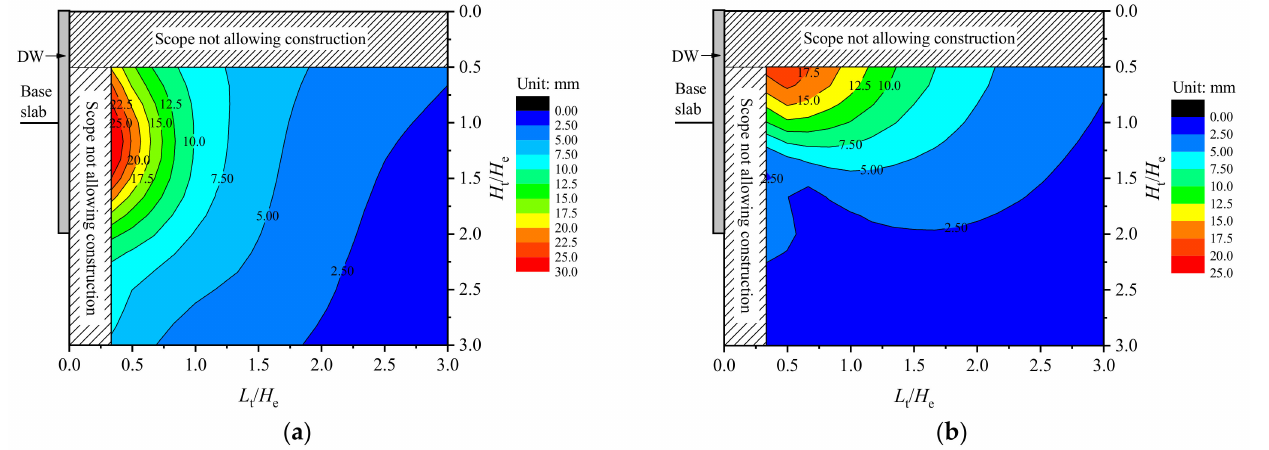
Figure 3. Isolines of tunnel displacements: ( a ) horizontal displacement isoline; ( b ) vertical displace- ment isoline.